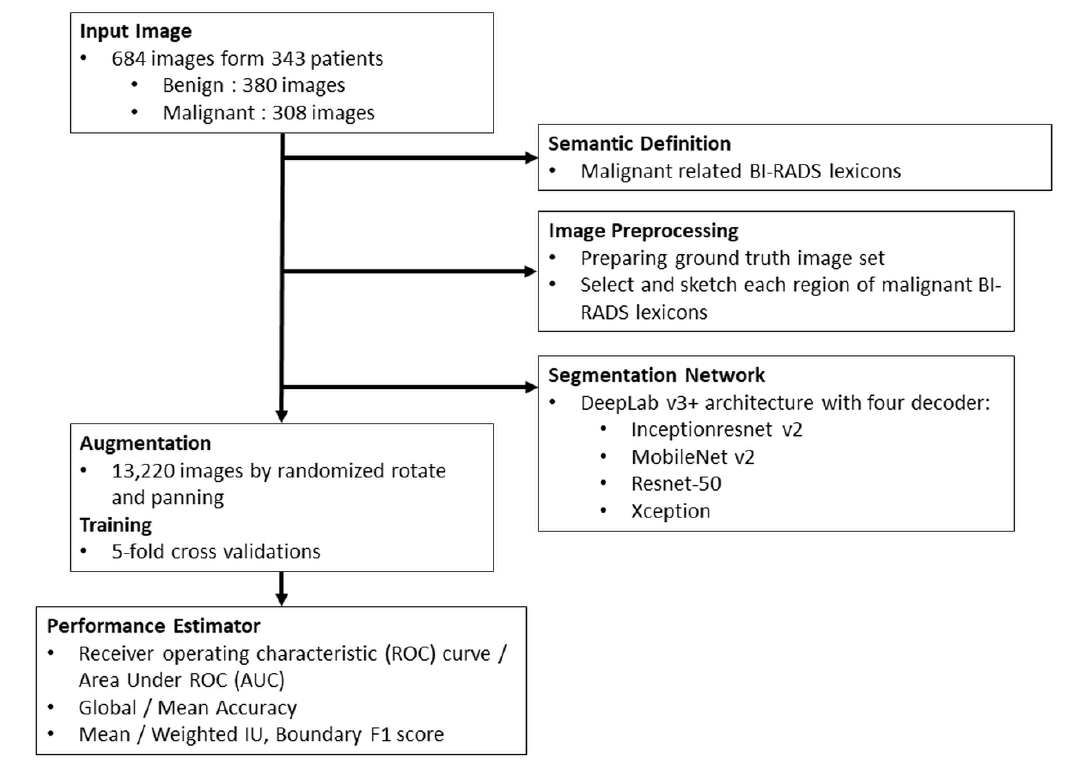
Figure 1. Flowchart of the study.